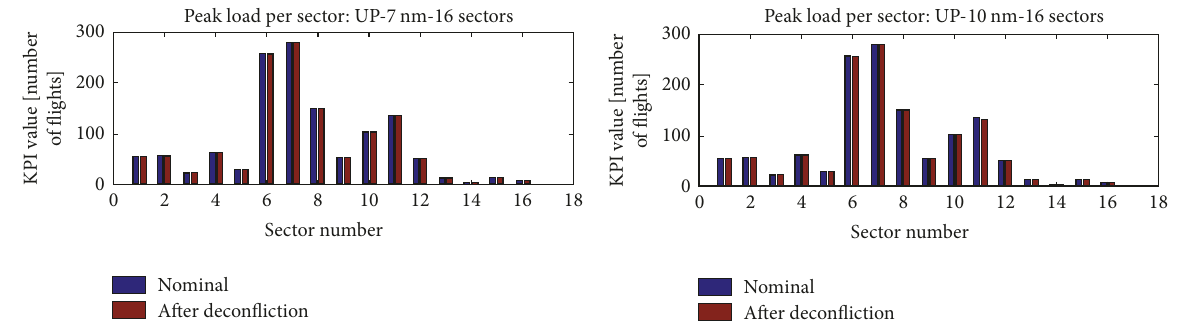
Figure 7: Peak load per sector in the analysis cases of 7 NM/16 sectors and 10NM/16